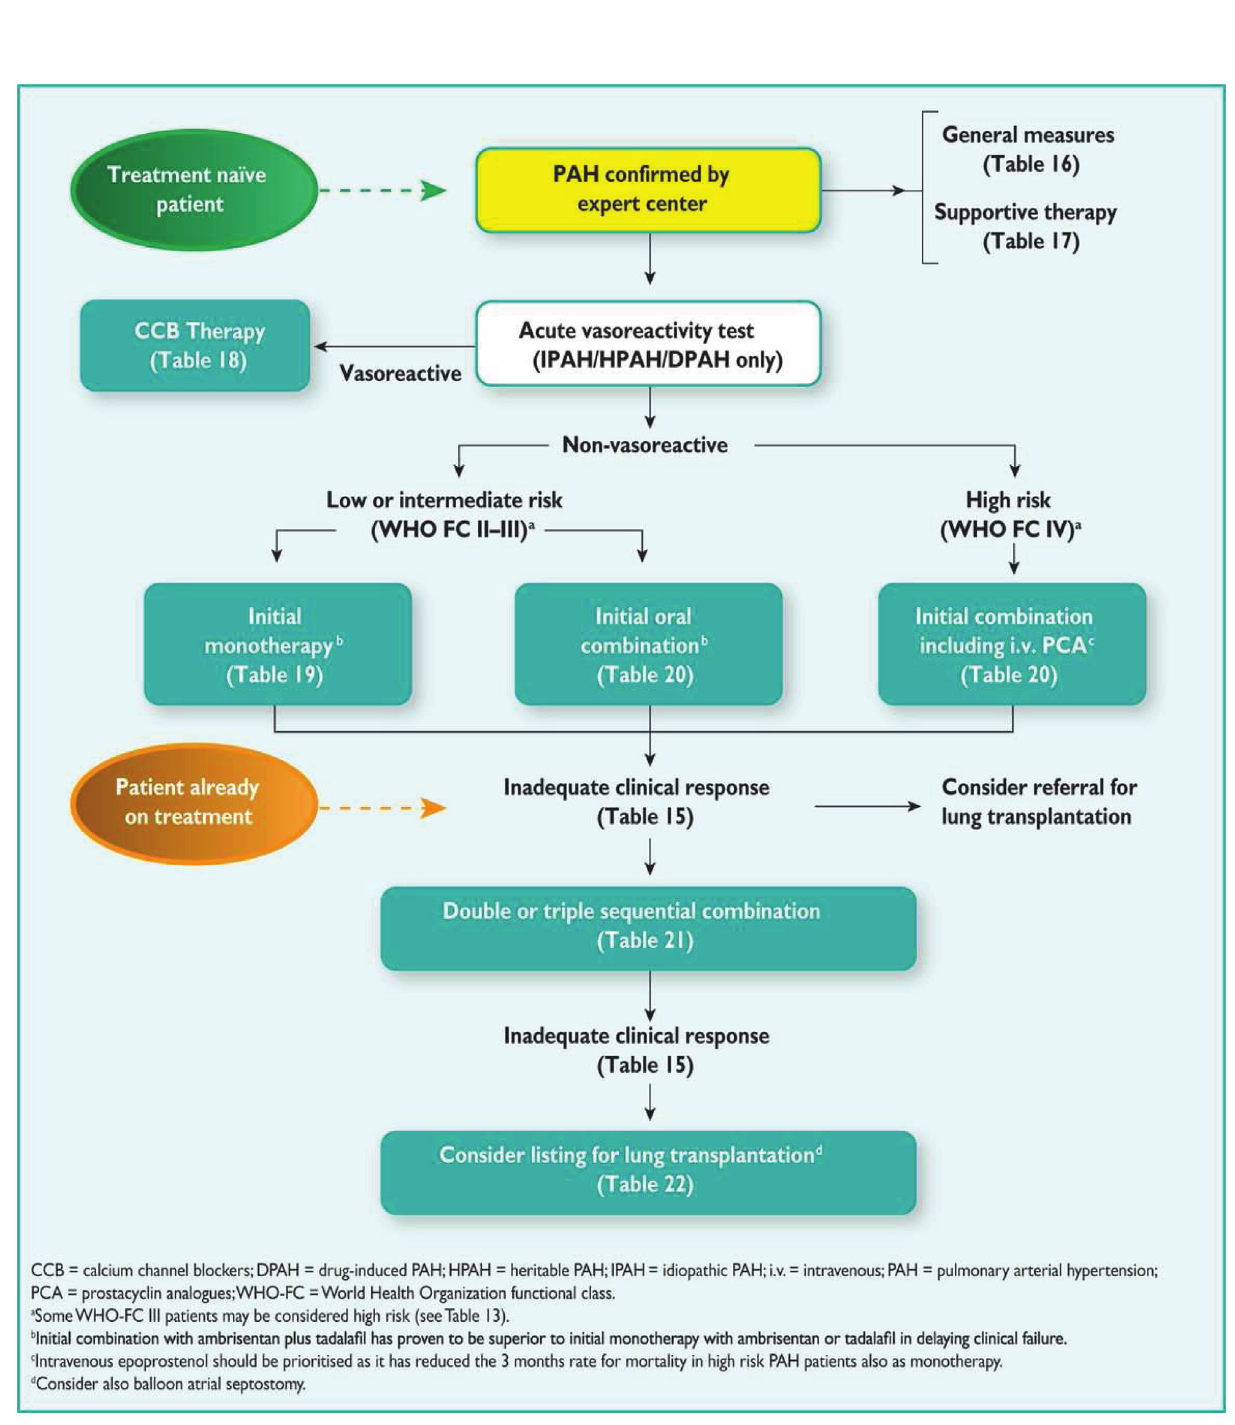
Figure 2. Treatment algorithm from the 2015 European Society of Cardiology/European Respiratory Society guidelines for the diagnosis and treatment of pulmonary hypertension. Reproduced with permission from the European Respiratory Society and European Society of Cardiology 2